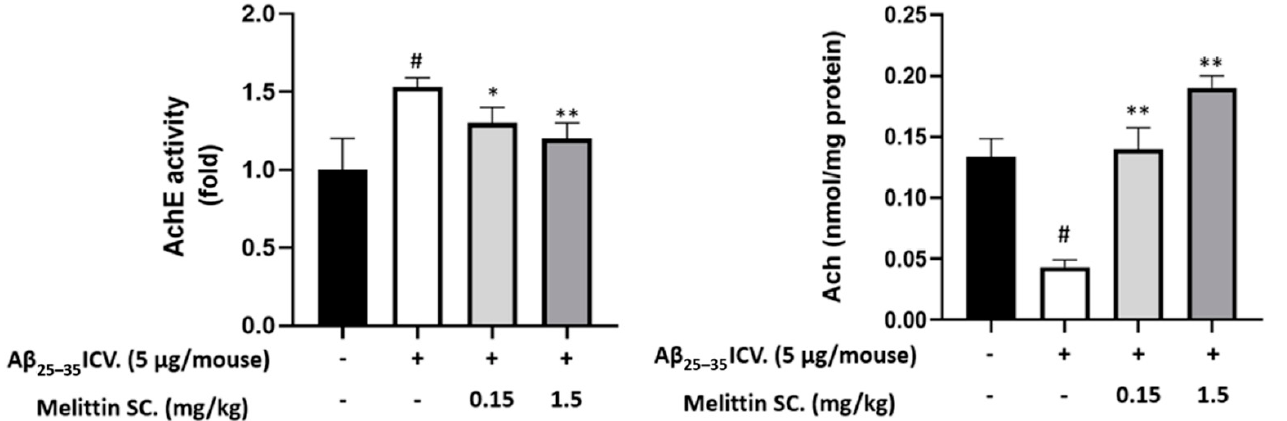
Figure 10. Levels of AchE activity and Ach content in the mouse brain. The cholinergic system exhibited ameliorations as melittin was administrated, against A β 25–35 ICV.-induced neurodegeneration. To conduct this experiment: Analysis were performed on hippocampal tissue as described in the materials and methods section. Data are presented as the mean ± standard error of the sextuple determinations. # p < 0.01 vs. control * p < 0.05 and ** p < 0.01 vs. A β 25–35 only-treated group.